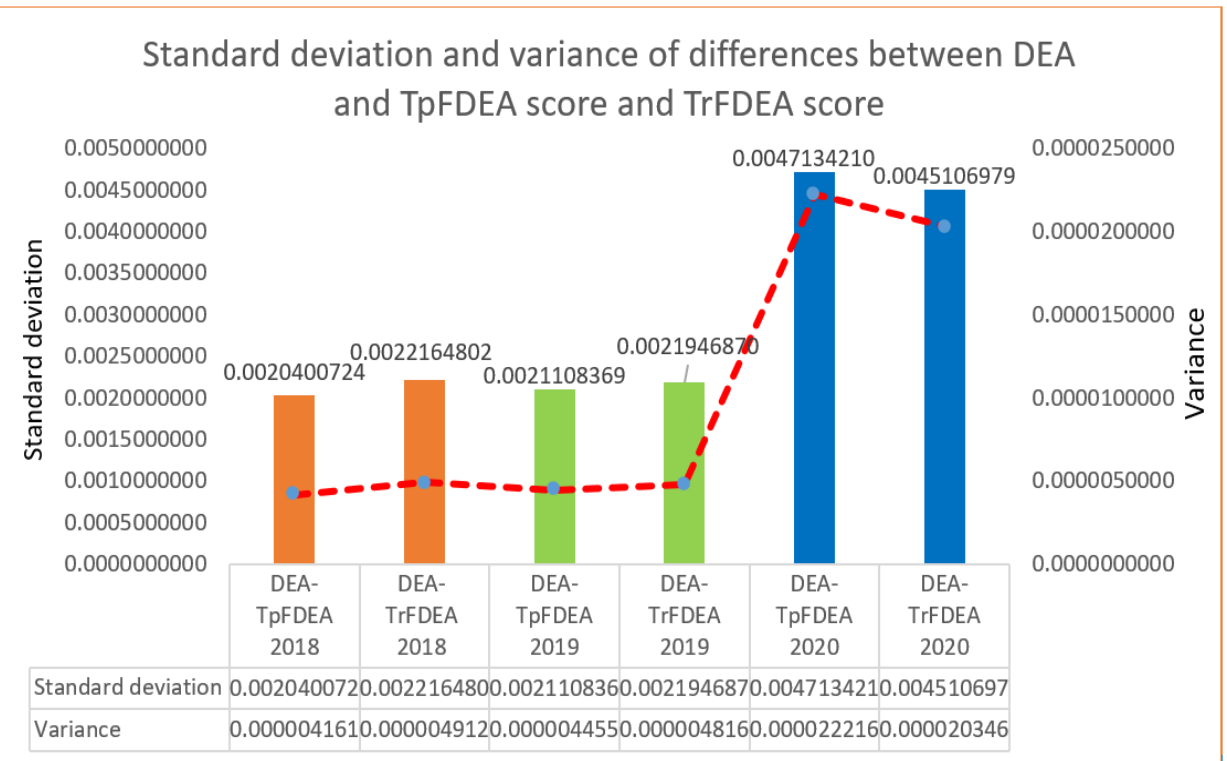
Figure 8. Comparison of standard deviations and variances between the TrFDEA and TpFDEA using the DEA as the relative reference.